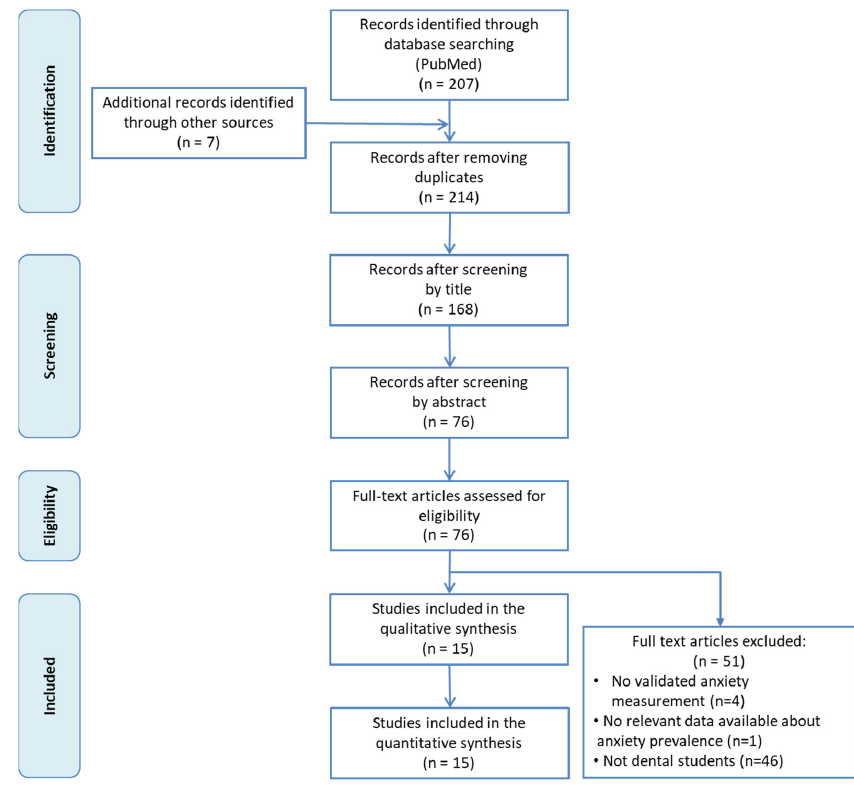
Figure 1. Flowchart of the study selection.